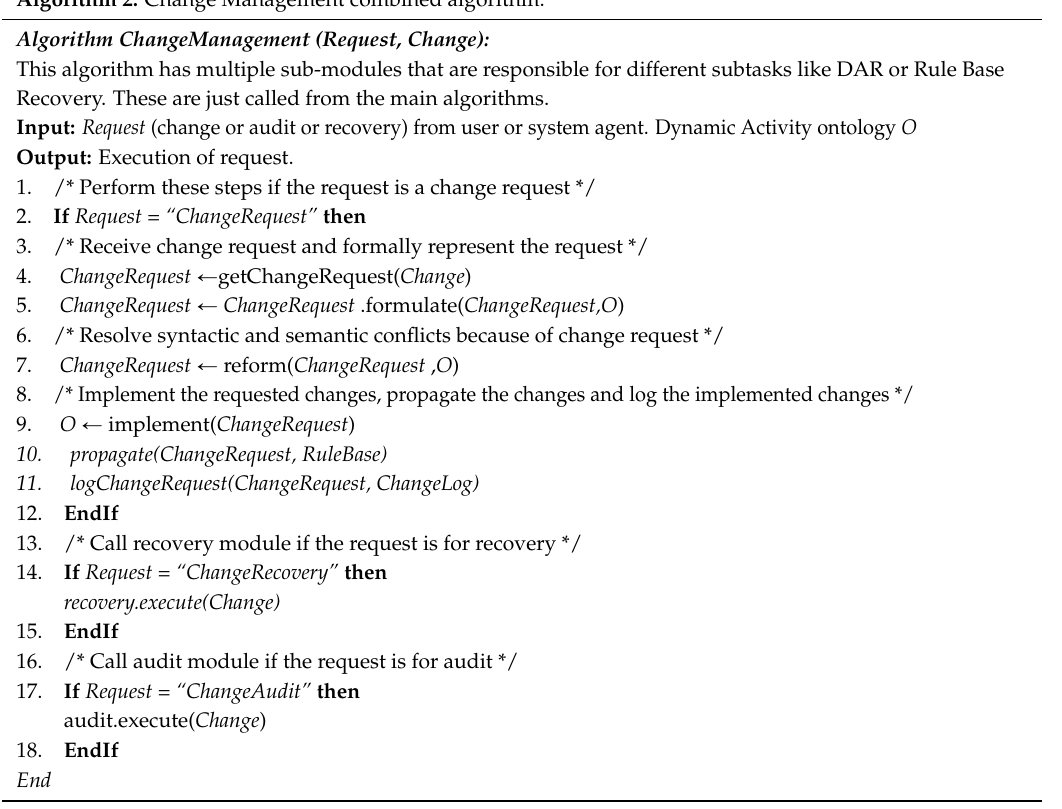
Algorithm 2. Change Management combined algorithm.